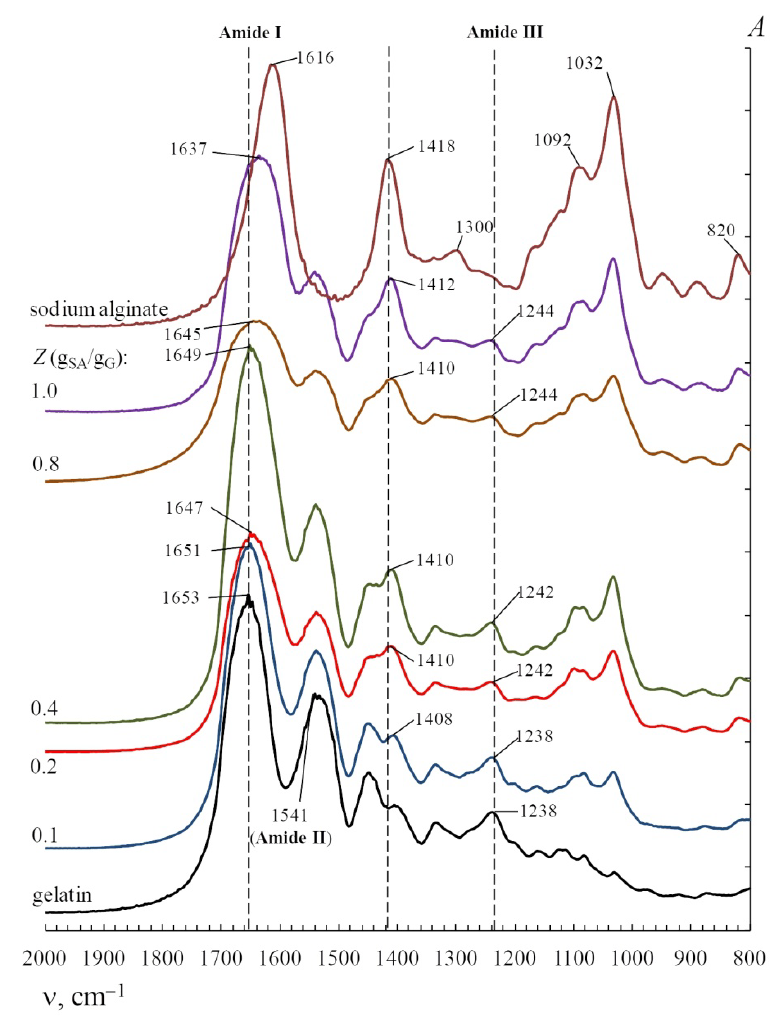
Figure 6. FT-IR spectra for native gelatin, native sodium alginate, and mixtures of gelatin and sodium alginate with different sodium alginate/gelatin w / w ratios Z , g SA /g G . Original figure.